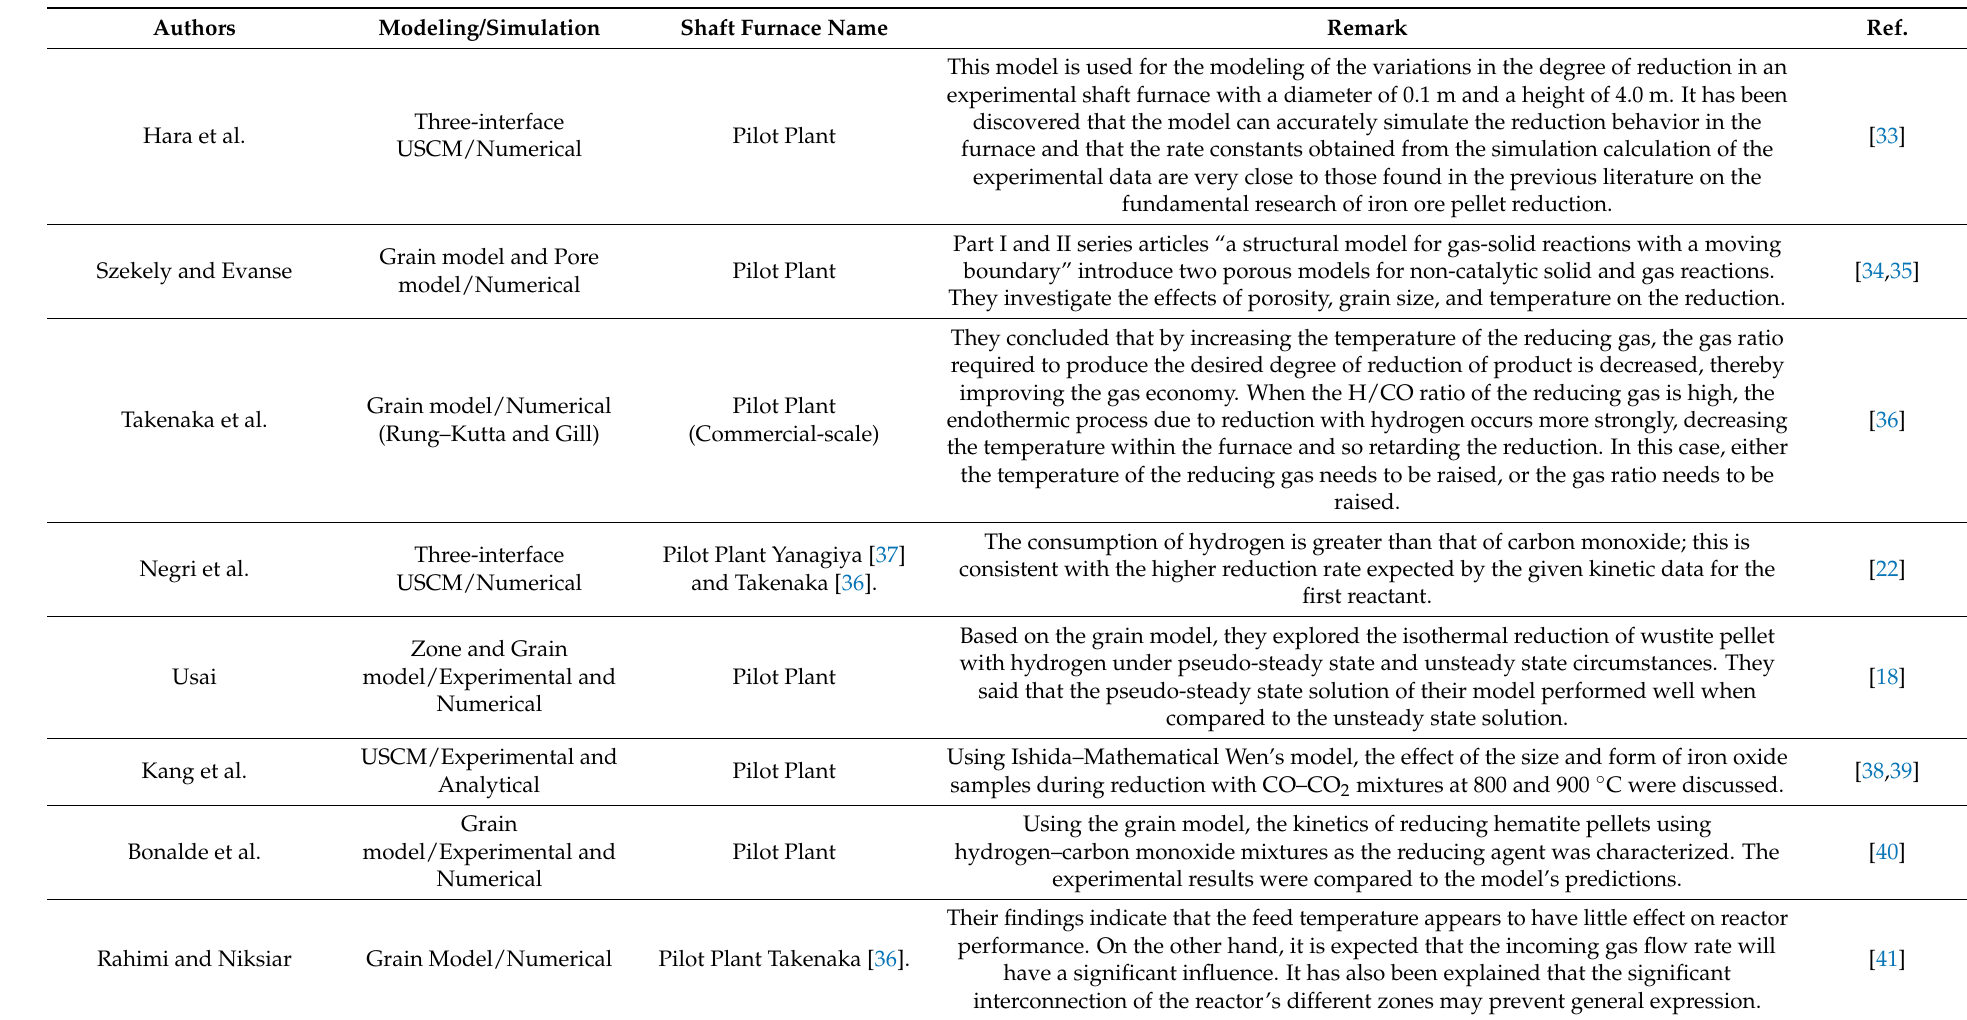
Table 2. Summarized simulation works using non-industrial modeling